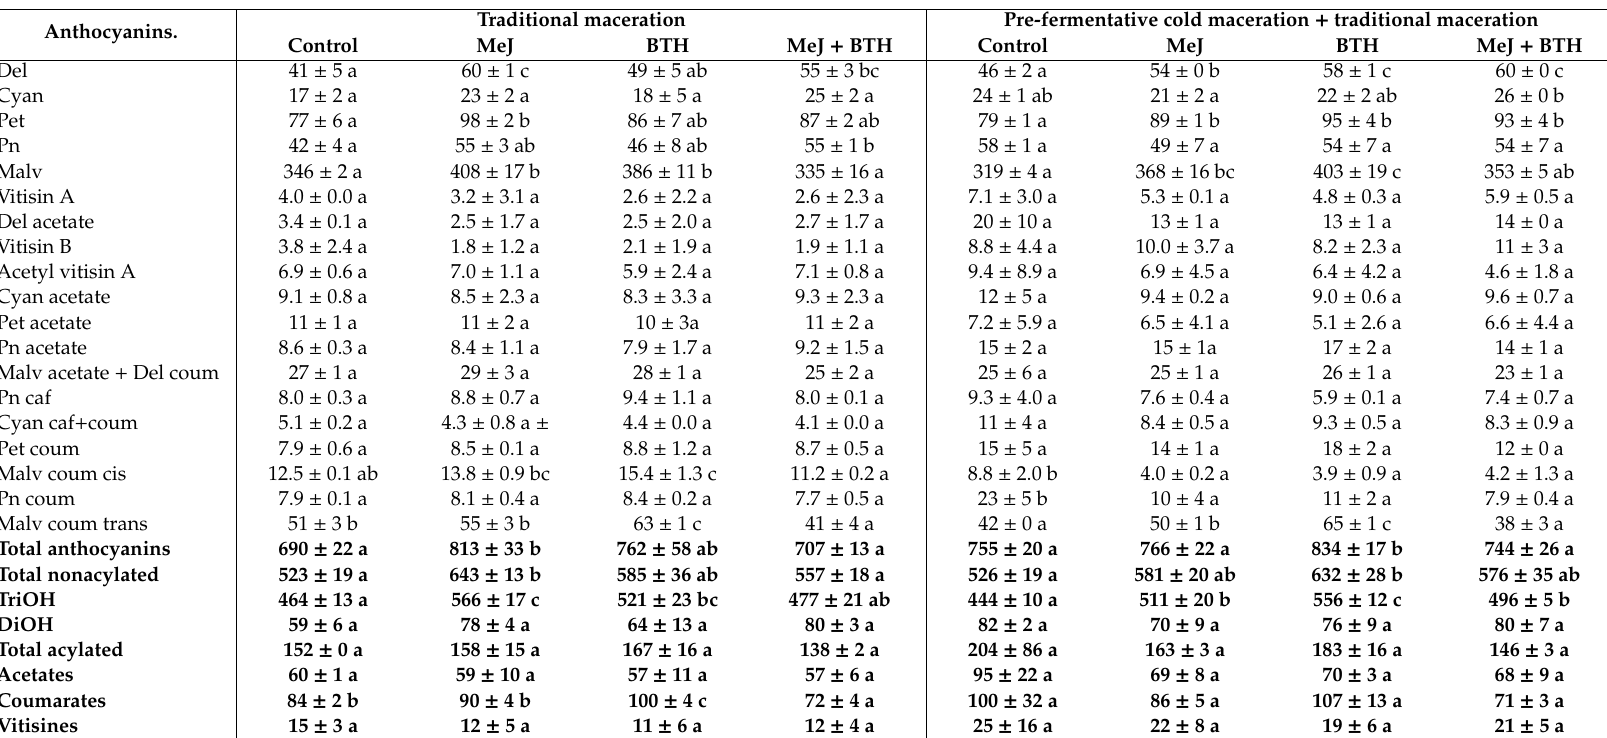
Table 4. Concentration of anthocyanins expressed as mg / L at the end of alcoholic fermentation in Monastrell wines ( 2016 ).